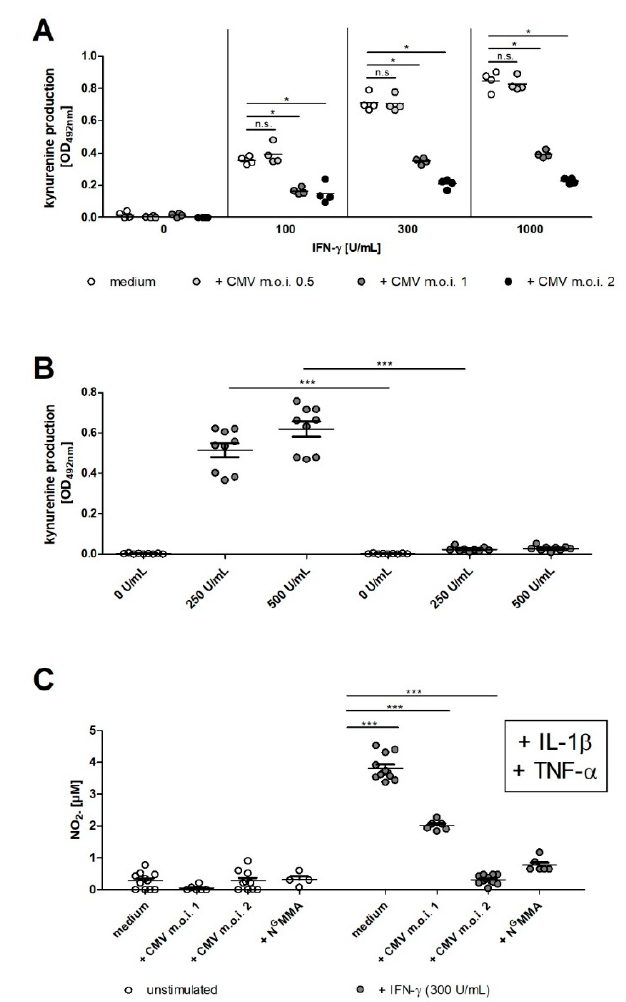
Figure 3. CMV infection results in lower IDO1 and iNOS activity in human RPE cells. 3 × 10 4 hRPE cells were stimulated in 96-well plates with indicated amounts of human IFN- γ (0 to 1000 U/mL) in the presence of CMV (MOI, 0.05–2) or N G MMA (100 µg/mL). After 72 h the cell culture supernatants were harvested and the kynurenine content was determined by optical density measurement at 492 nm, using Ehrlich’s reagent ( A , B ) or the nitrite content was quantified by measuring the optical density at 540 nm, using Griess reagent ( C ). Data are given as mean ± SEM of three experiments, each performed in triplicate. Significant differences to the unstimulated or uninfected group were marked with asterisks (n.s. = not significant; * p ≤ 0.05; and *** p ≤ 0.0001). The nonparametric Mann–Whitney U test was